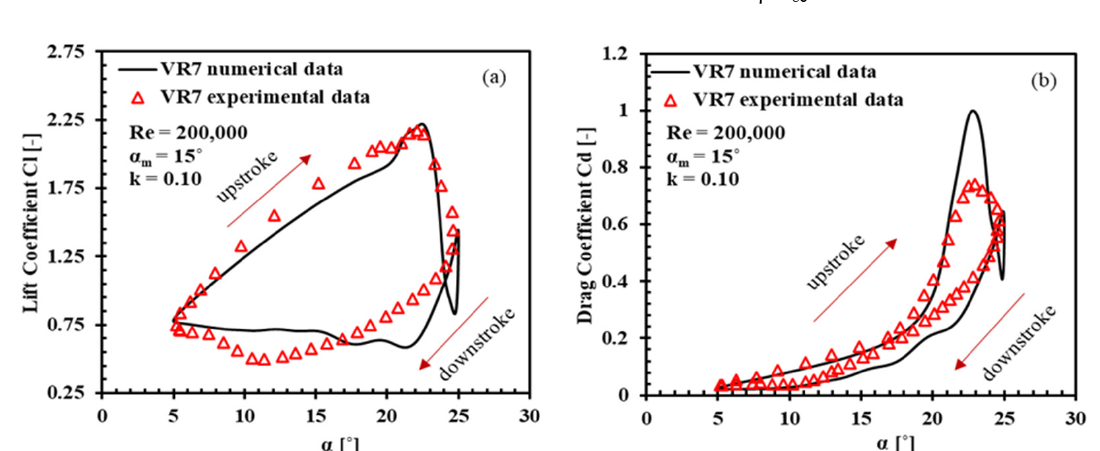
Figure 4. Validation of the pitch oscillating airfoil case utilizing VR7 airfoil experimental data to compare ( a ) coefficients of lift and ( b ) drag.